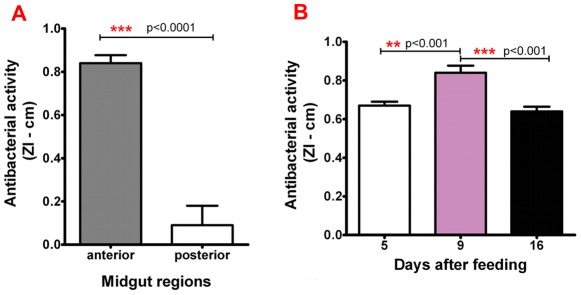
Antibacterial activity using inhibition zone (ZI) assay in Rhodnius prolixus 5th-instar nymphs infected with Trypanosoma cruzi Dm28c clone.(A) Antibacterial activity with anterior and posterior midgut regions at 9 days after feeding; (B) Antibacterial activity of anterior midgut at 5, 9 and 16 days after feeding. Bars represent mean ± SEM. Means were analyzed by using t Test and 1 way ANOVA. Each bar represents the mean (+/−SEM) of four separate experiment, n = 6−10 insects for each determination.